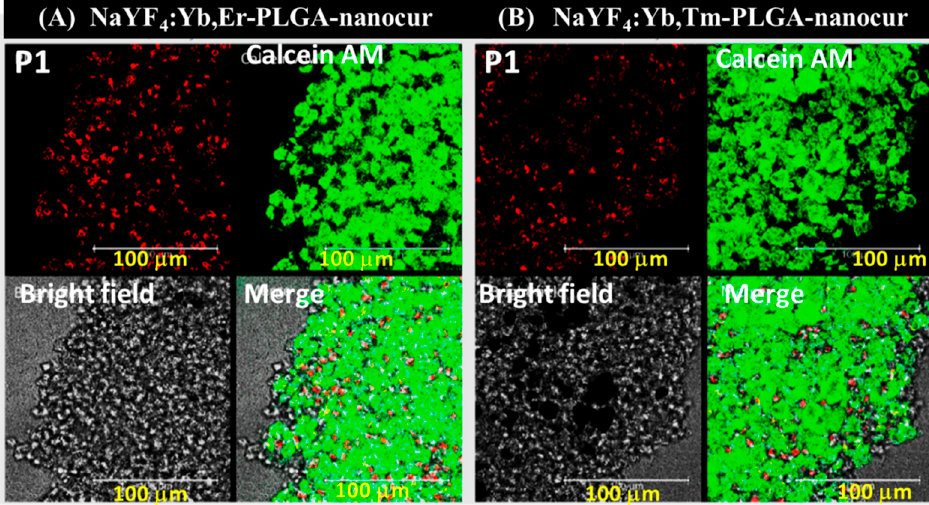
Figure 10. Confocal fluorescent microscopy micrographs of rat glioma C6 spheroids incubated with 0.4 mg/mL UCNPs for 48 h, NaYF 4 :YbEr PLGA nanocur ( A ) and NaYF 4 :YbTm PLGA nanocur ( B ) The spheroids were stained with propidium iodide (dead cells, in red) and calcein AM (alive cells, in green), scale bar is 100 μ m.